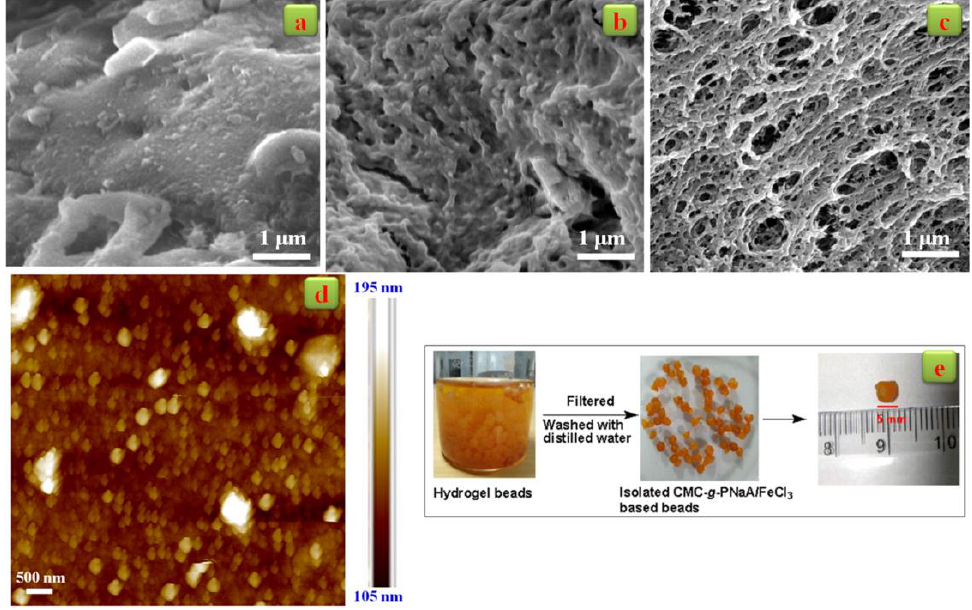
Figure 6. Scanning electron microscopy (SEM) images of ( a ) CMC; ( b ) CMC- g -PNaA; and ( c ) CMC- g -PNaA / FeCl 3 ; ( d ) atomic force microscopy (AFM) image of CMC- g -PNaA / FeCl 3 hydrogel bead; and ( e ) isolated beads of CMC- g -PNaA / FeCl 3 .